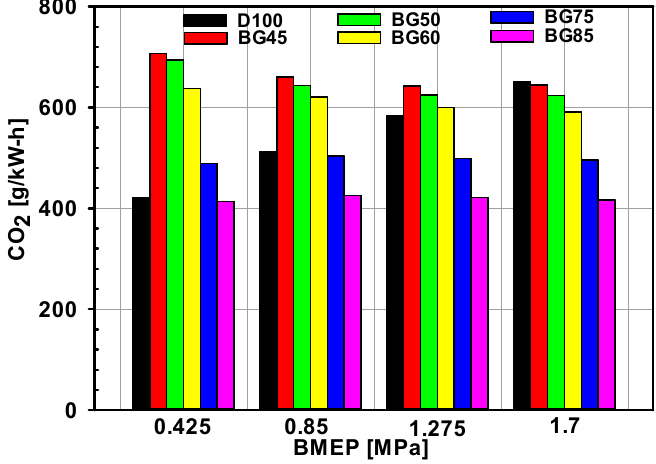
Figure 12. Variation of CO 2 emissions with engine load.